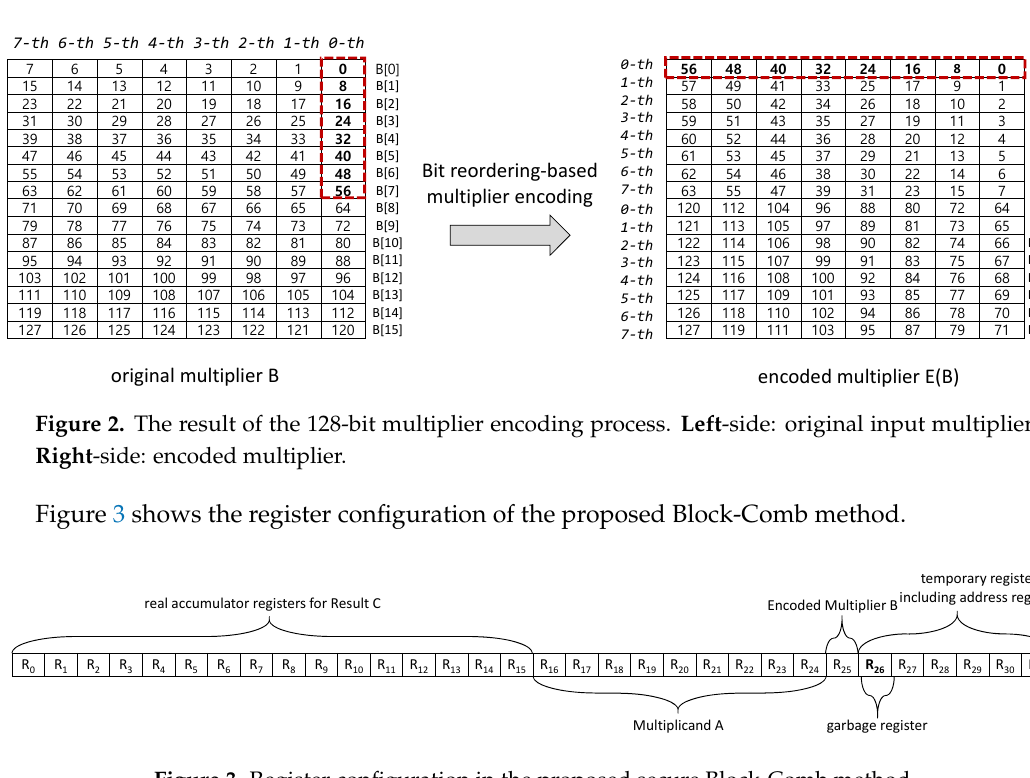
Figure 3. Register configuration in the proposed secure Block-Comb